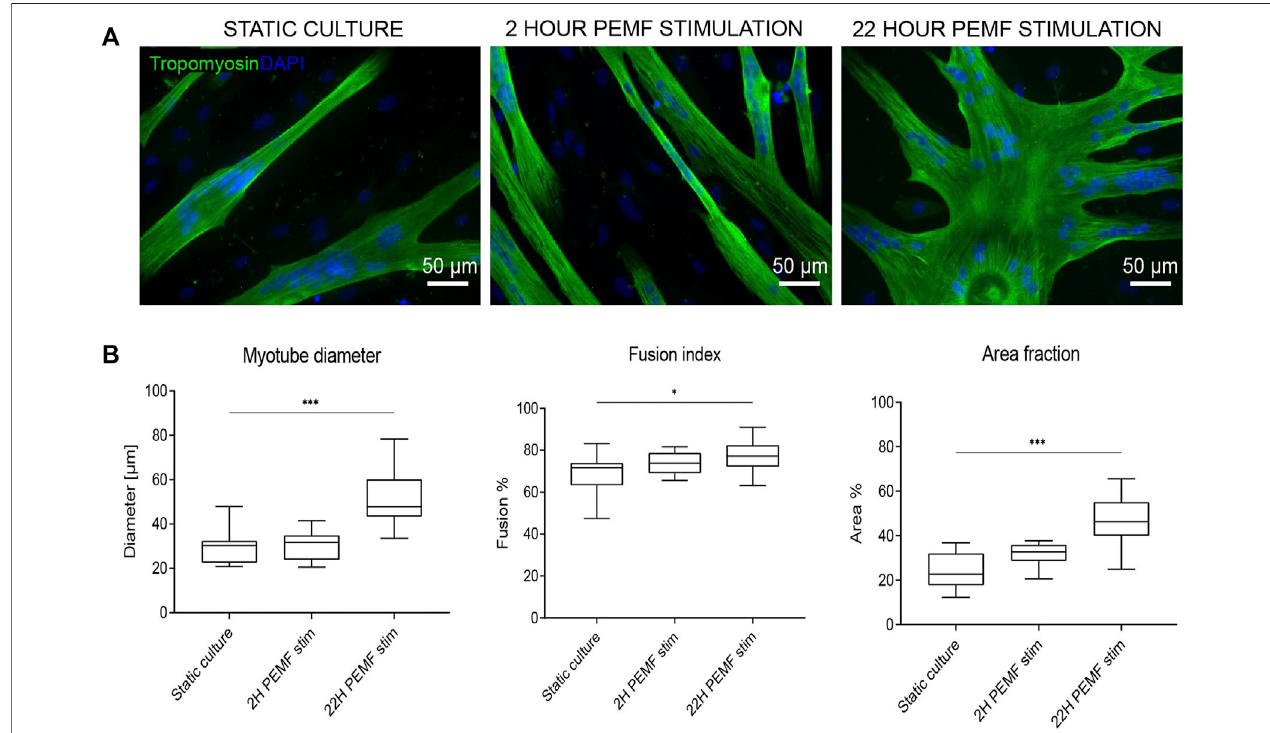
FIGURE 2 | (A) Tropomyosin staining of 2D samples after no, 2 h per day or 22 h per day PEMF stimulation for 4 days. Blue: nuclei stained with DAPI; green: myotubes stained fortropomyosin. Scale bars: 50 µm. (B) Quanti fi cation from the tropomyosin staining images via Fijisoftware, diameter (left), fusion index (middle) and area fraction (% of surface covered by cells) (right) (* p < 0.05, ** p < 0.01, *** p < 0.001) (n = 3 experimental replicates, for each 5 random images were